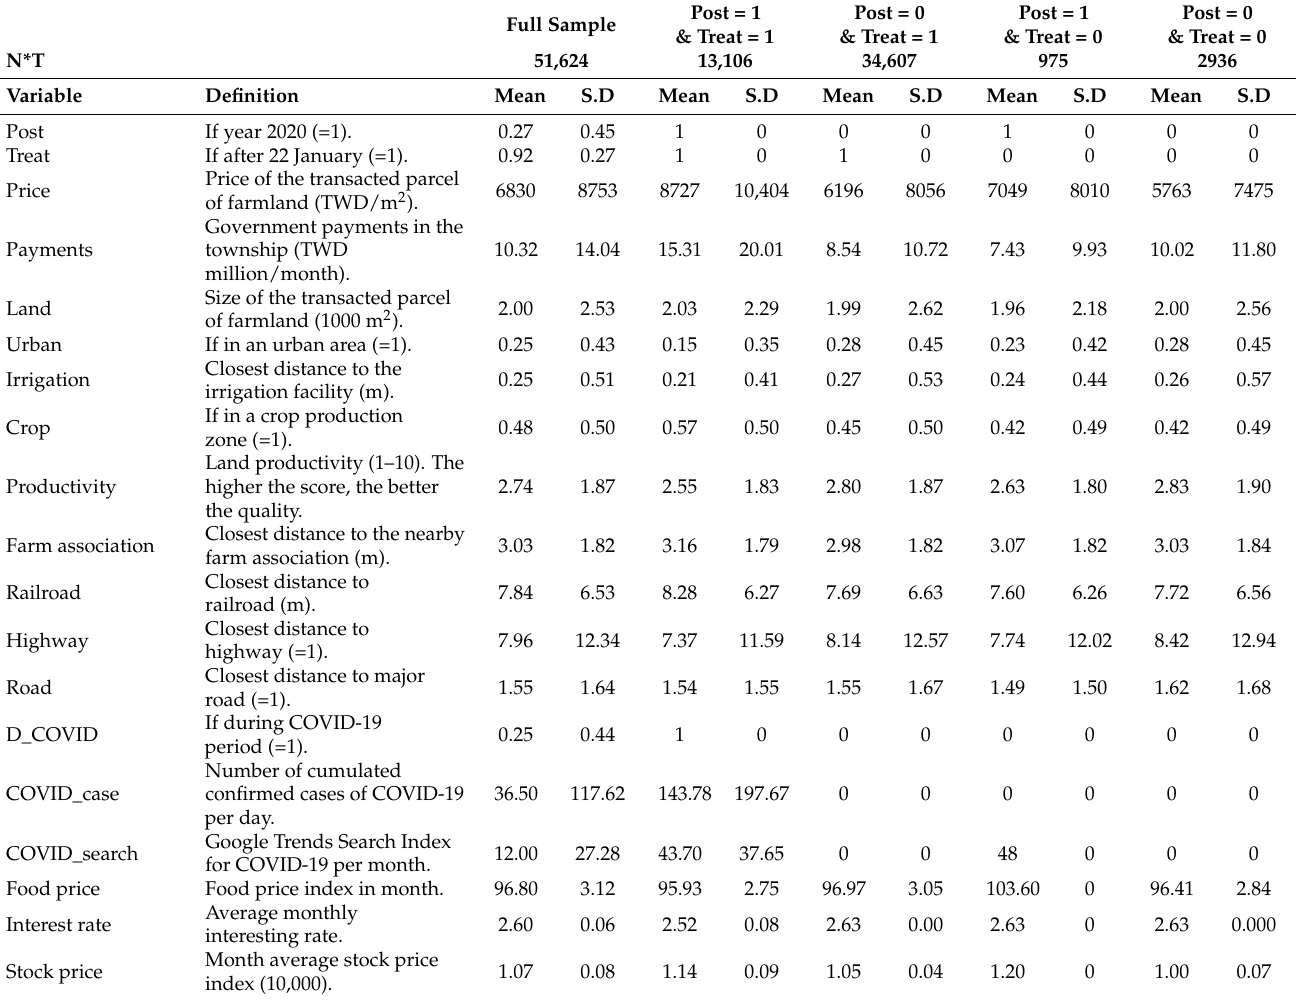
Table 2. Sample statistics of the selected